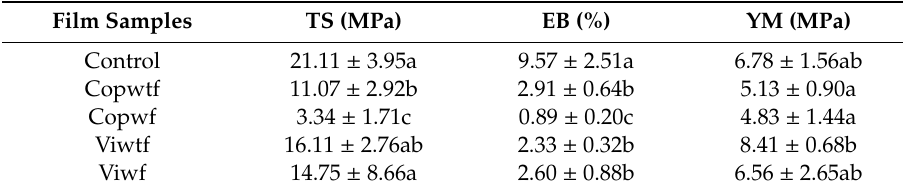
Table 3. Tensile strength (TS), elongation at break (EB) and young´s modulus (YM) of Copena F1 without fibre (Copwtf), Copena F1 with fibre (Copwf), Villanueva without fibre (Viwtf) and Villanueva with fibre (Viwf)